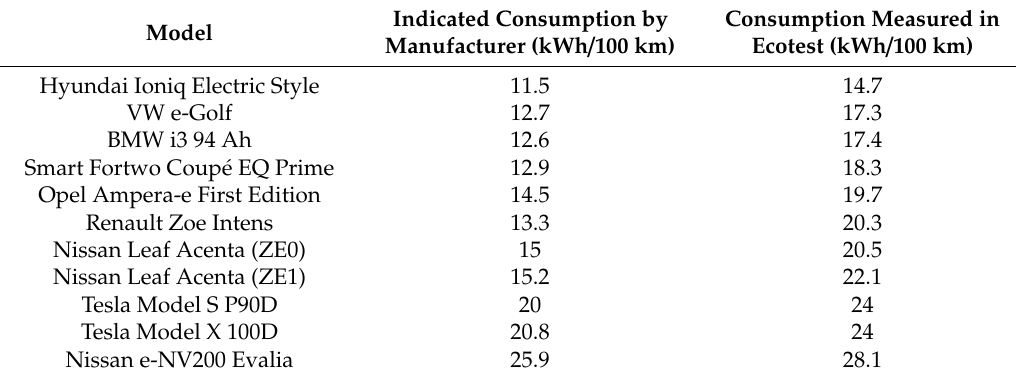
Table 1. Indicated versus real energy consumption (German Automobile Club (ADAC) [8]). Indicated Consumption by Consumption Measured in Model Manufacturer (kWh / 100 km) Ecotest (kWh / 100